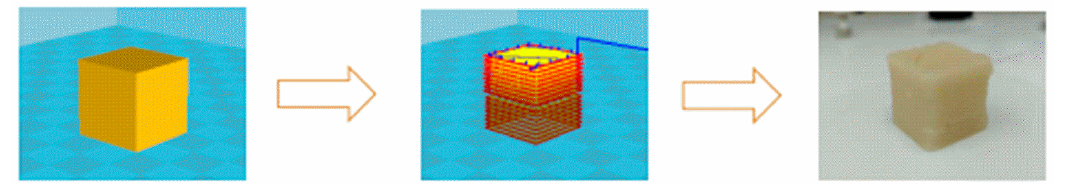
Figure 1. The general process of 3D printing.